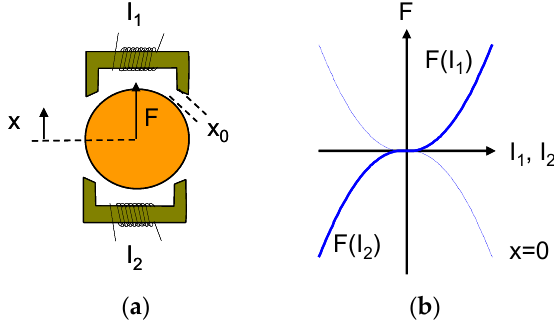
Figure 3. Setup requiring a non-linear control strategy: I 1 > 0, I 2 = 0 for F > 0 and I 1 = 0, I 2 < 0 for F < 0. ( a ) Coil arrangement without bias current; ( b ) Non-linear current-force relationship.